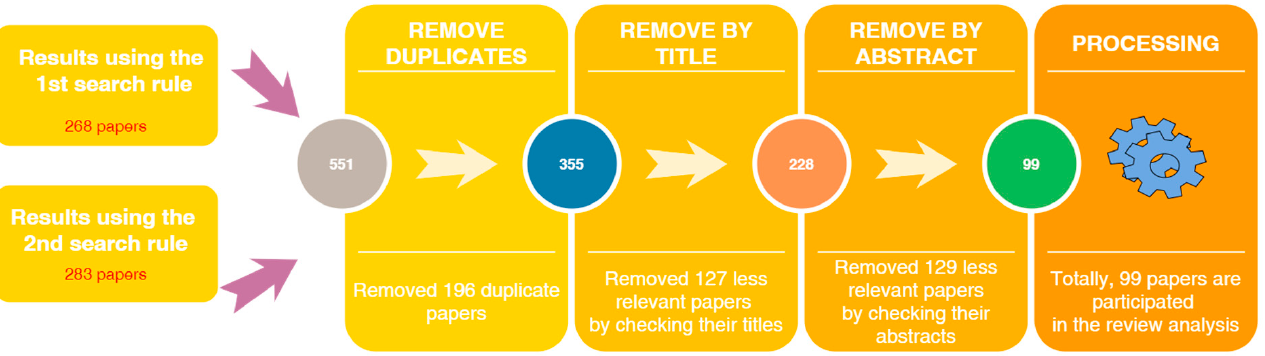
Figure 1. Source selection procedure.